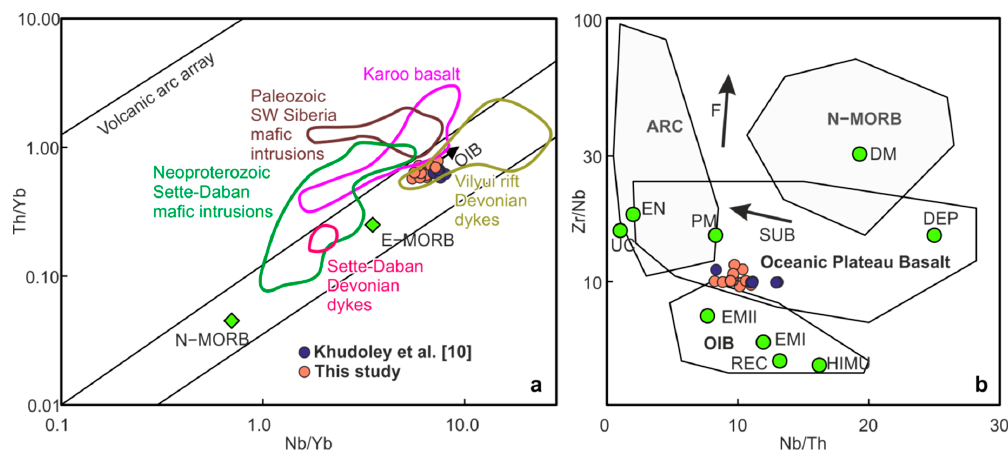
Figure 15. ( a ) Th/Yb–Nb/Yb diagram Suordakh event mafic intrusions [76]. Data source for Devonian Sette-Daban dykes [29], Devonian Vilyui rift dykes [29,45], Karoo basalts [51], Neoproterozoic (1000- 950 Ma) intrusions, SE Siberia [30], early Paleozoic intrusions, SW Siberia [74]. ( b ) Zr/Nb–Nb/Th plot [77]. Abbreviations: UC—upper continental crust; PM—primitive mantle; DM—shallow depleted mantle; HIMU— high µ ( 238 U/ 204 Pb) mantle source; EMI and EMII—enriched mantle sources; ARC— arc-related basalts; N-MORB—normal mid ocean ridge basalt; OIB—oceanic island basalt; DEP— deep depleted mantle; EN—enriched component; and REC—recycled component. Arrows indicate effects of batch melting (F) and subduction (SUB).